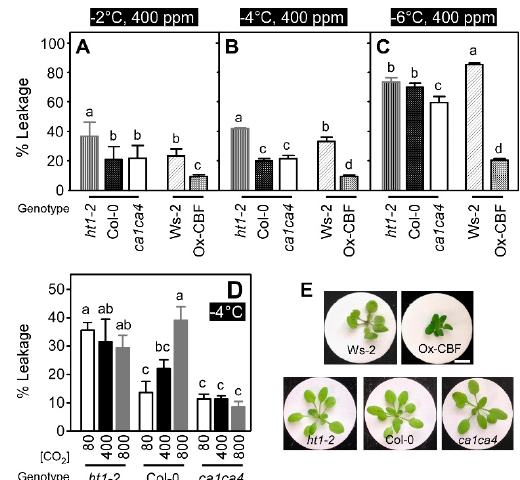
Figure 4. Defects in stomatal responses to CO 2 alter freezing tolerance in Arabidopsis. Electrolyte leakage was analyzed using Arabidopsis stomatal response mutant ( ht1-2 , ca1ca4 ) ant their wild-type ecotype, Col-0, as well as a CBF3 over-expression plant (Ox-CBF) and its wild-type ecotype, Ws-2. Individual 3.5-week-old plants ( E ) were initially incubated at 4 °C for 3 h at ambient CO 2 . The chamber temperature was then lowered at 1 °C h − 1 and plants were sampled for electrolyte leakage at − 2 ( A ), − 4 ( B ), and − 6 °C ( C ). Electrolyte leakage under varying CO 2 levels at − 4 °C ( D ) was examined. Electrolyte leakage into deionized water was measured as changes of conductivity and the percentages shown are mean values from three biological replicates and two technical replicates (error bars indicate SEM). Bars labeled with different lowercase letters differed at p ≤ 0.05 and differences were determined using One-way ( A – C ), Two-way ANOVA ( D ) and Tukey HSD ( A – D ).